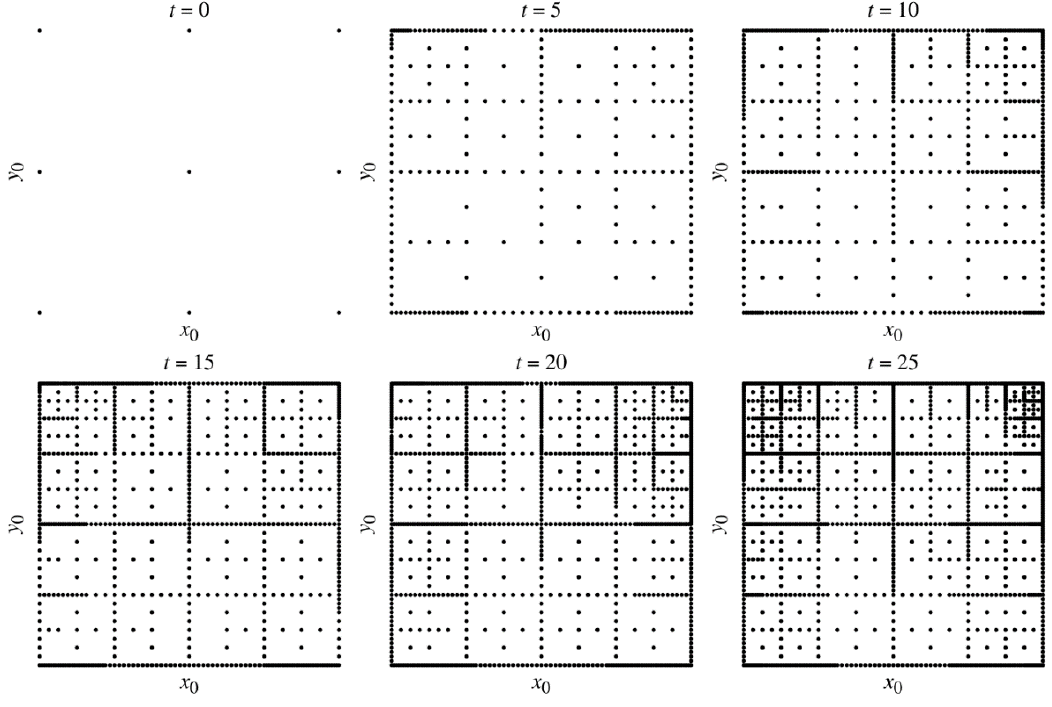
Figure 9. The grids obtained in the process of solving system given by Equation (9).